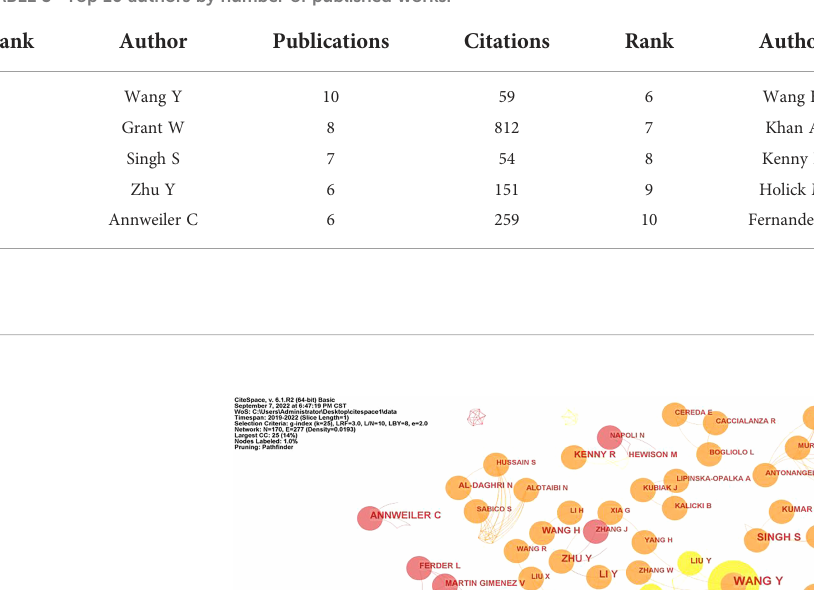
TABLE 5 Top 10 authors by number of published works.